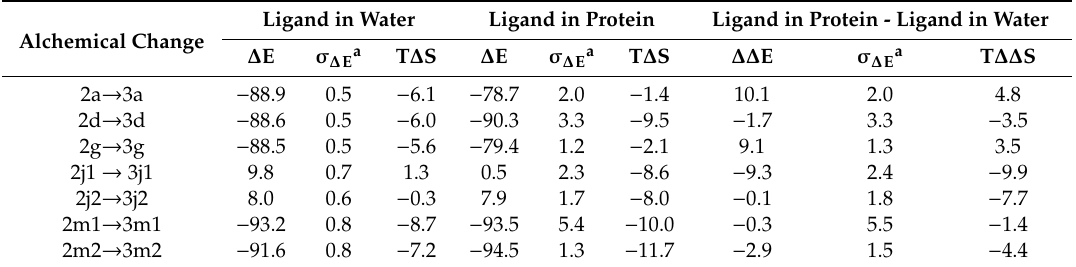
Table 4. Energetic and Entropic Contributions of Di ff erent Ligand Transformations in kJ / mol. Alchemical